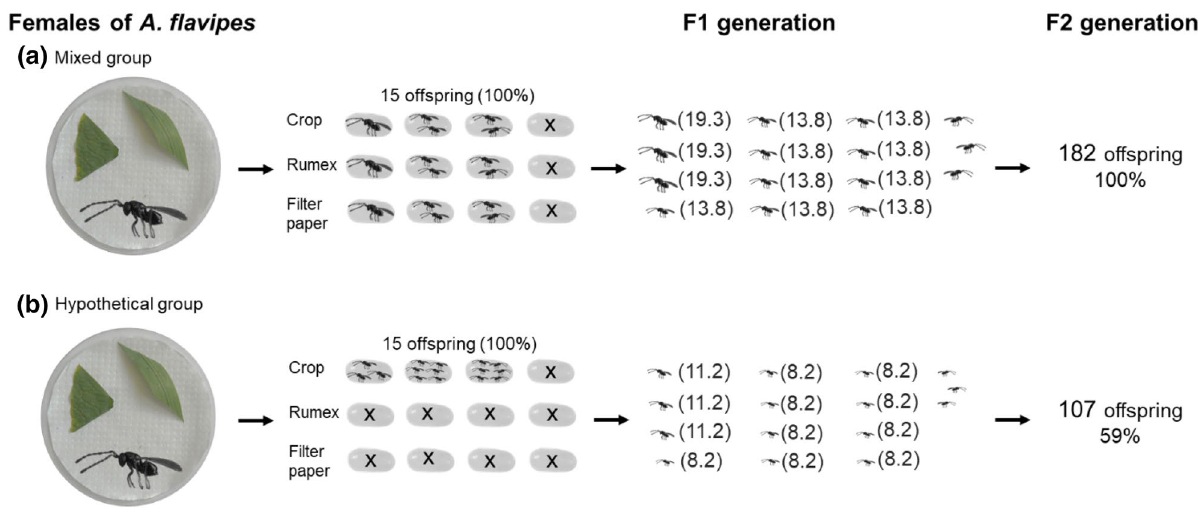
Figure 3. A hypothetical scenario showing the importance of a two-generation approach; the females have host eggs for parasitation offered on the usual host plant (crop), fictitious host plant ( Rumex ) and control substrate (filter paper). ( a ) the female, which accepts the all host eggs offered on the different host plans (real scenario (Suppl. Mat. 4)) and ( b ) the female, which accepts the only host eggs offered on the usual host plant may have the same fertility in F1 generation, but using different clutch size, they obtain different fertility in F2 generation (fertility was determined according to Samková et al. 45 ). (*The fertility values (shown in parentheses); The offspring sex ratio of A. flavipes is 3:1 (male:female) 46 ; females are shown as (left oriented) and males as (right